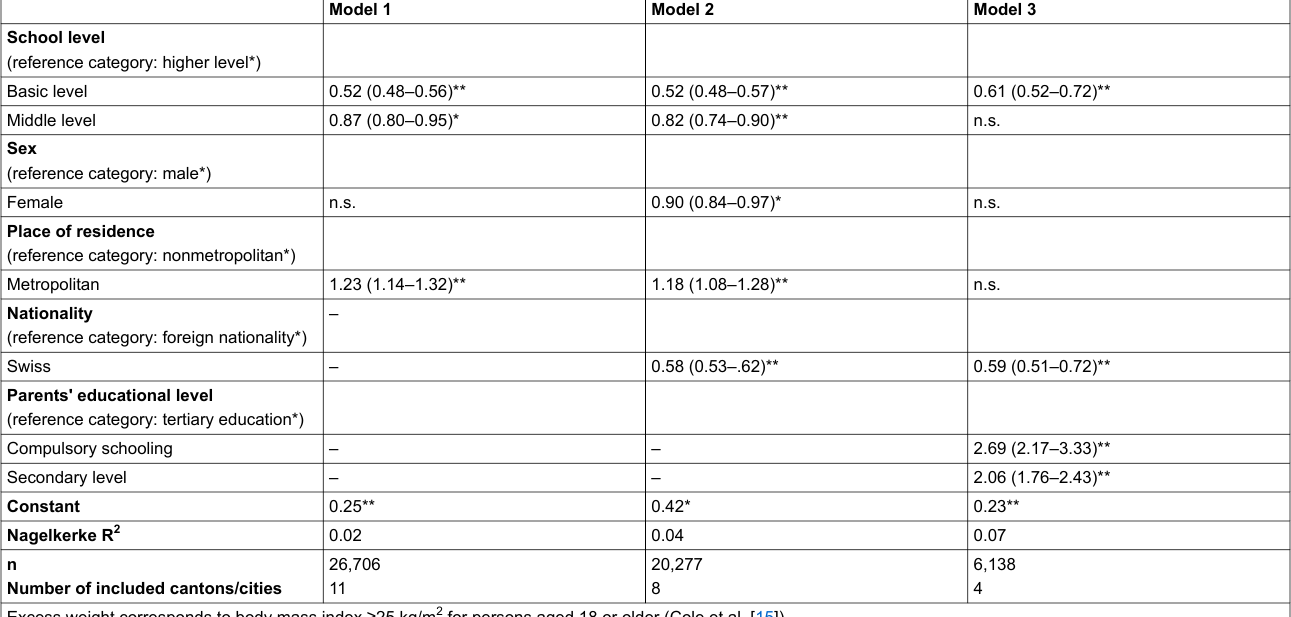
Table 6: Odds ratios of different multivariate logistic regression models with excess weight (overweight plus obesity) as dependent variable (confidence intervals in parentheses, p